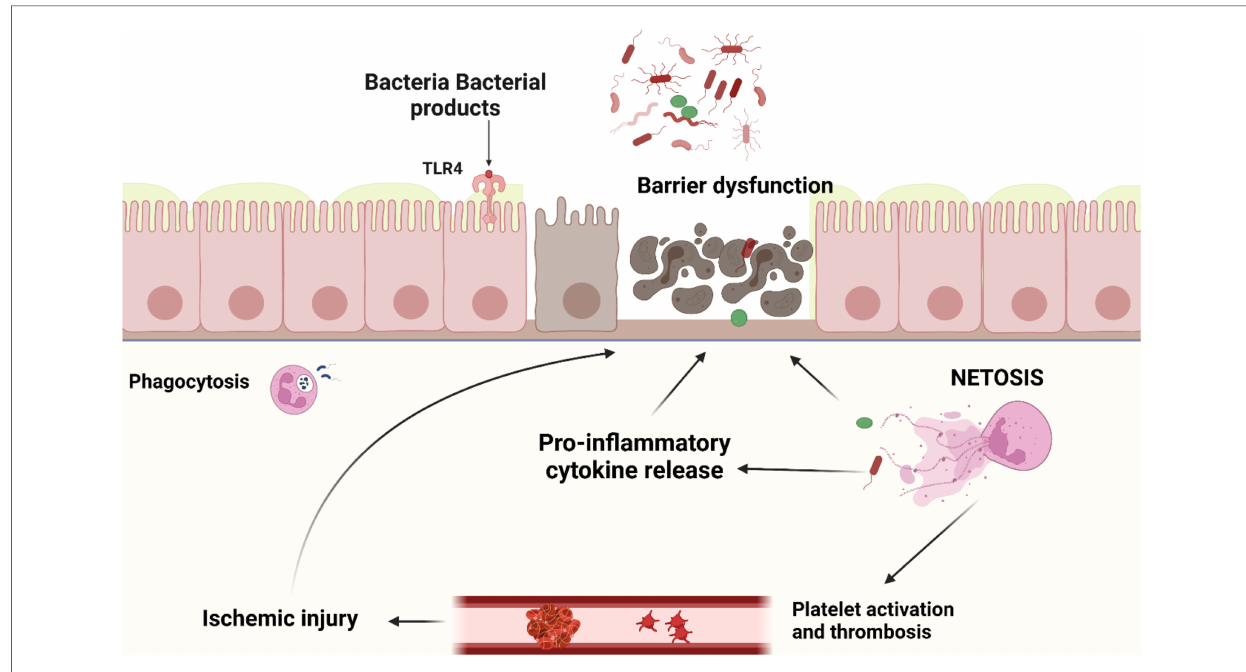
FIGURE 1 Neutrophil activation and NETs release in intestinal tissue of NEC patients occur as a result of various stimuli such as pathological bacteria, PAMPs and ROS. Though NETs and their components are important to prevent bacterial translocation through the intestine, dysregulated NETs release leads to adjacent epithelial and endothelial injury, cytokine release, platelet activation and thrombus formation. This would result in a vicious cycle of tissue necrosis, further immune activation, ischemia reperfusion injury, uncontrolled in fl ammation, multi-organ failure, and